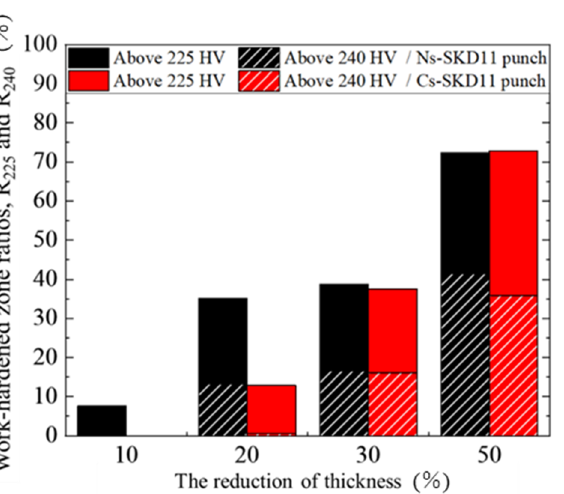
Figure 10. Variation of the work-hardening area in the forged pure titanium wire with the increasing reduction in thickness.